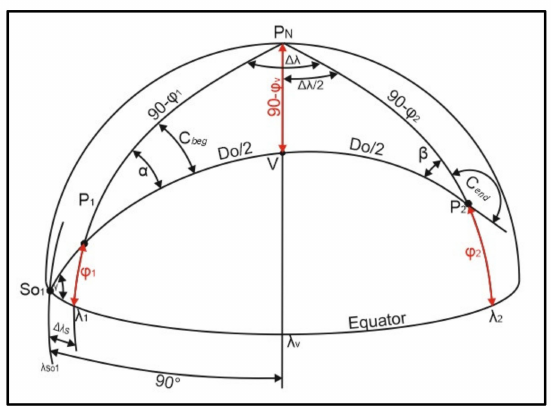
Figure 1. Elements of great circle navigation.